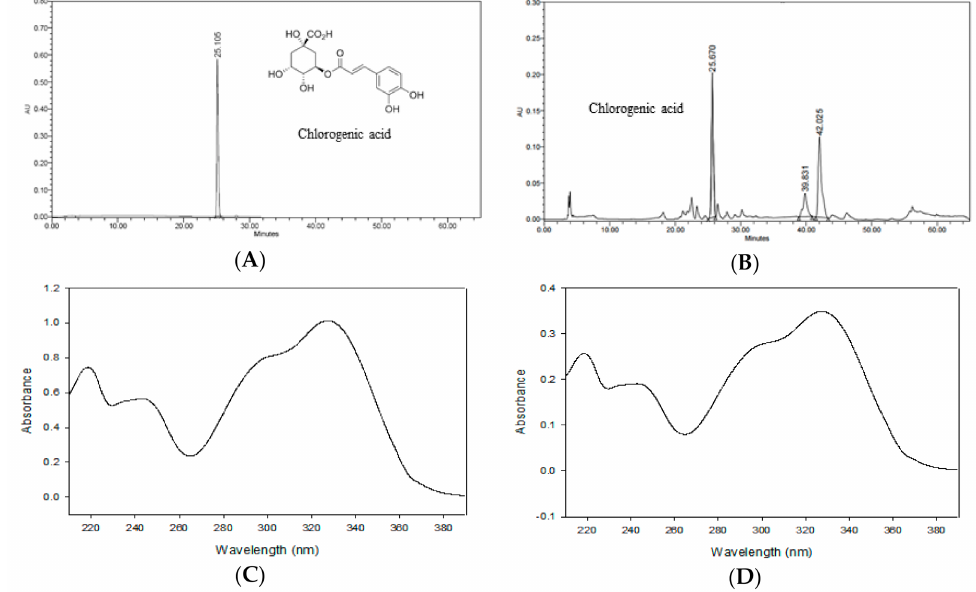
Figure 2. HPLC chromatograms of chlorogenic acid ( A ) and the ASE ( B ). Photodiode array (PDA) spectrum of chlorogenic acid ( C ) and ASE ( D ) from the